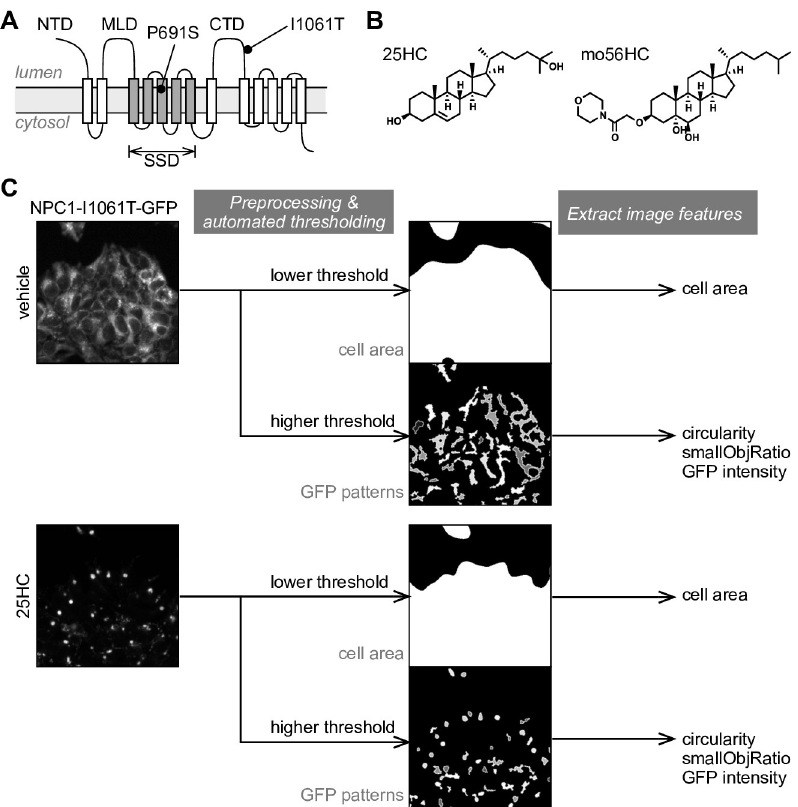
Fig 1. An image-based screen for chaperone drugs that correct mis-localization of NPC1-I1061T-GFP. (A) Schematic representation of the topology of NPC1 and the positions of P691S and I1061T mutations in the protein. The following abbreviations are used to denote the domains of NPC1; NTD, N-terminal domain; MLD, mid luminal domain; SSD, sterol-sensing domain; CTD, C-terminal luminal domain. (B) Structures of oxysterol-based pharmacological chaperones for NPC1-I1061T mutant protein. (C) Illustration of the image processing procedure used to extract the NPC1-I1061T-GFP localization pattern and relevant image features. From the resulting images, the cell area and GFP distribution patterns are extracted by applying automated thresholding. From the GFP patterns, morphological features that reflect localization changes from ER to LE/L, including circularity and smallObjRatio, were calculated and used for quantifying the chaperone